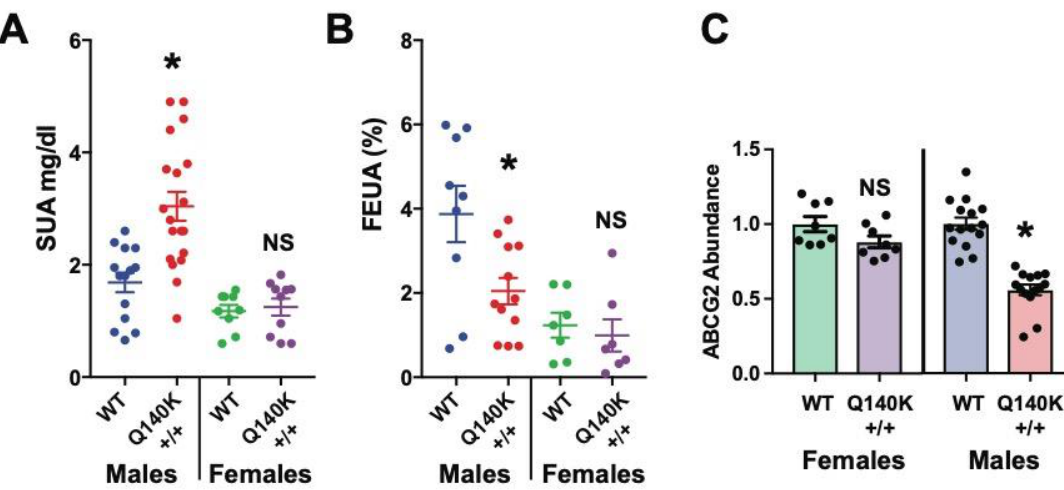
Figure 3. Female metabolic comparisons and ABCG2 abundance in ABCG2-Q140K mice. ( A ) Serum urate levels for male and female mice: WT and Q140K +/+ animals (WT females n = 9; Q140K +/+ n = 10; p = 0.7113, two-tailed Student’s t-test; males, n = 14 WT, and n = 19 Q140K +/+ ; * p < 0.0001, ± SEM). ( B ) Fractional excretion of urate (FEUA) measurements from female WT ( n = 7) and female Q140K +/+ ( n = 7, p = 0.6263, two-tailed Student’s t-test; males, n = 10 WT, and n = 12 Q140K +/+ ; * p = 0.0196, ± SEM). ( C ) Summary data from Western blots of total kidney homogenate from female WT ( n = 8) and female Q140K +/+ ( n = 8) mice showed no change in abundance of the Q140K +/+ protein ( p = 0.0835, two-tailed Student’s t-test. (Males, n = 15 WT, and n = 14 Q140K +/+ ; * p < 0.0001, ± SEM). NS = non-significant. Adapted from Hoque et al., Nature Communications [130] as allowed under